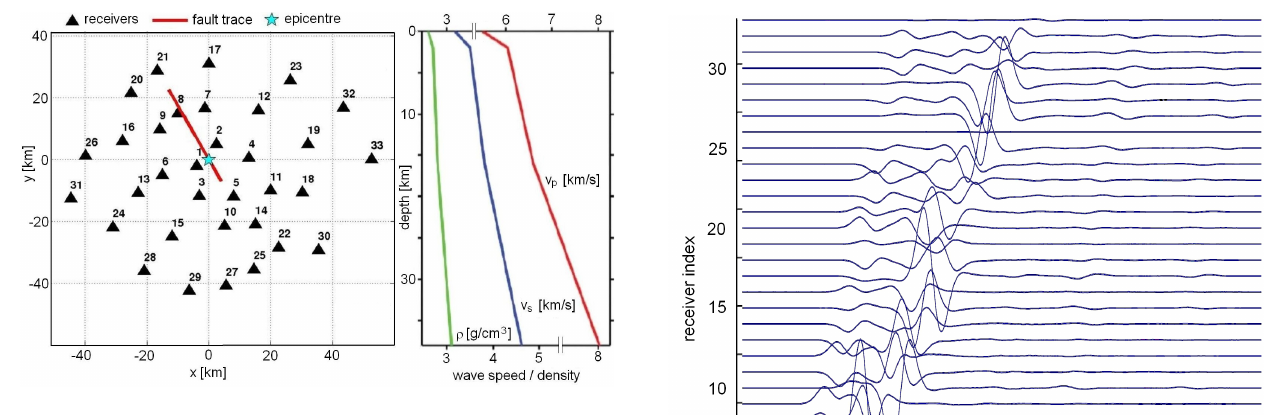
Fig. 1. Left: Geographic model setup. Stations are marked by trian- gles. The red line and the star mark the fault trace and the epicentre for the finite-fault simulations in Sect. 4. Right: Velocity and den- sity model used in all synthetic simulations.